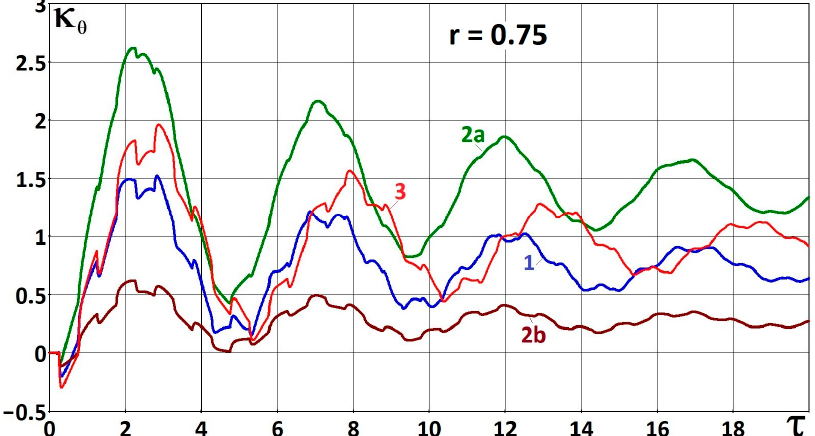
Figure 7. Time history of the relative circumferential stress at r = 0.75. Viscoelastic materials. FGM cylinder—curve 1; two-layer cylinder—curves 2a (inner layer) and 2b (outer layer); homogeneous cylinder—curve 3.